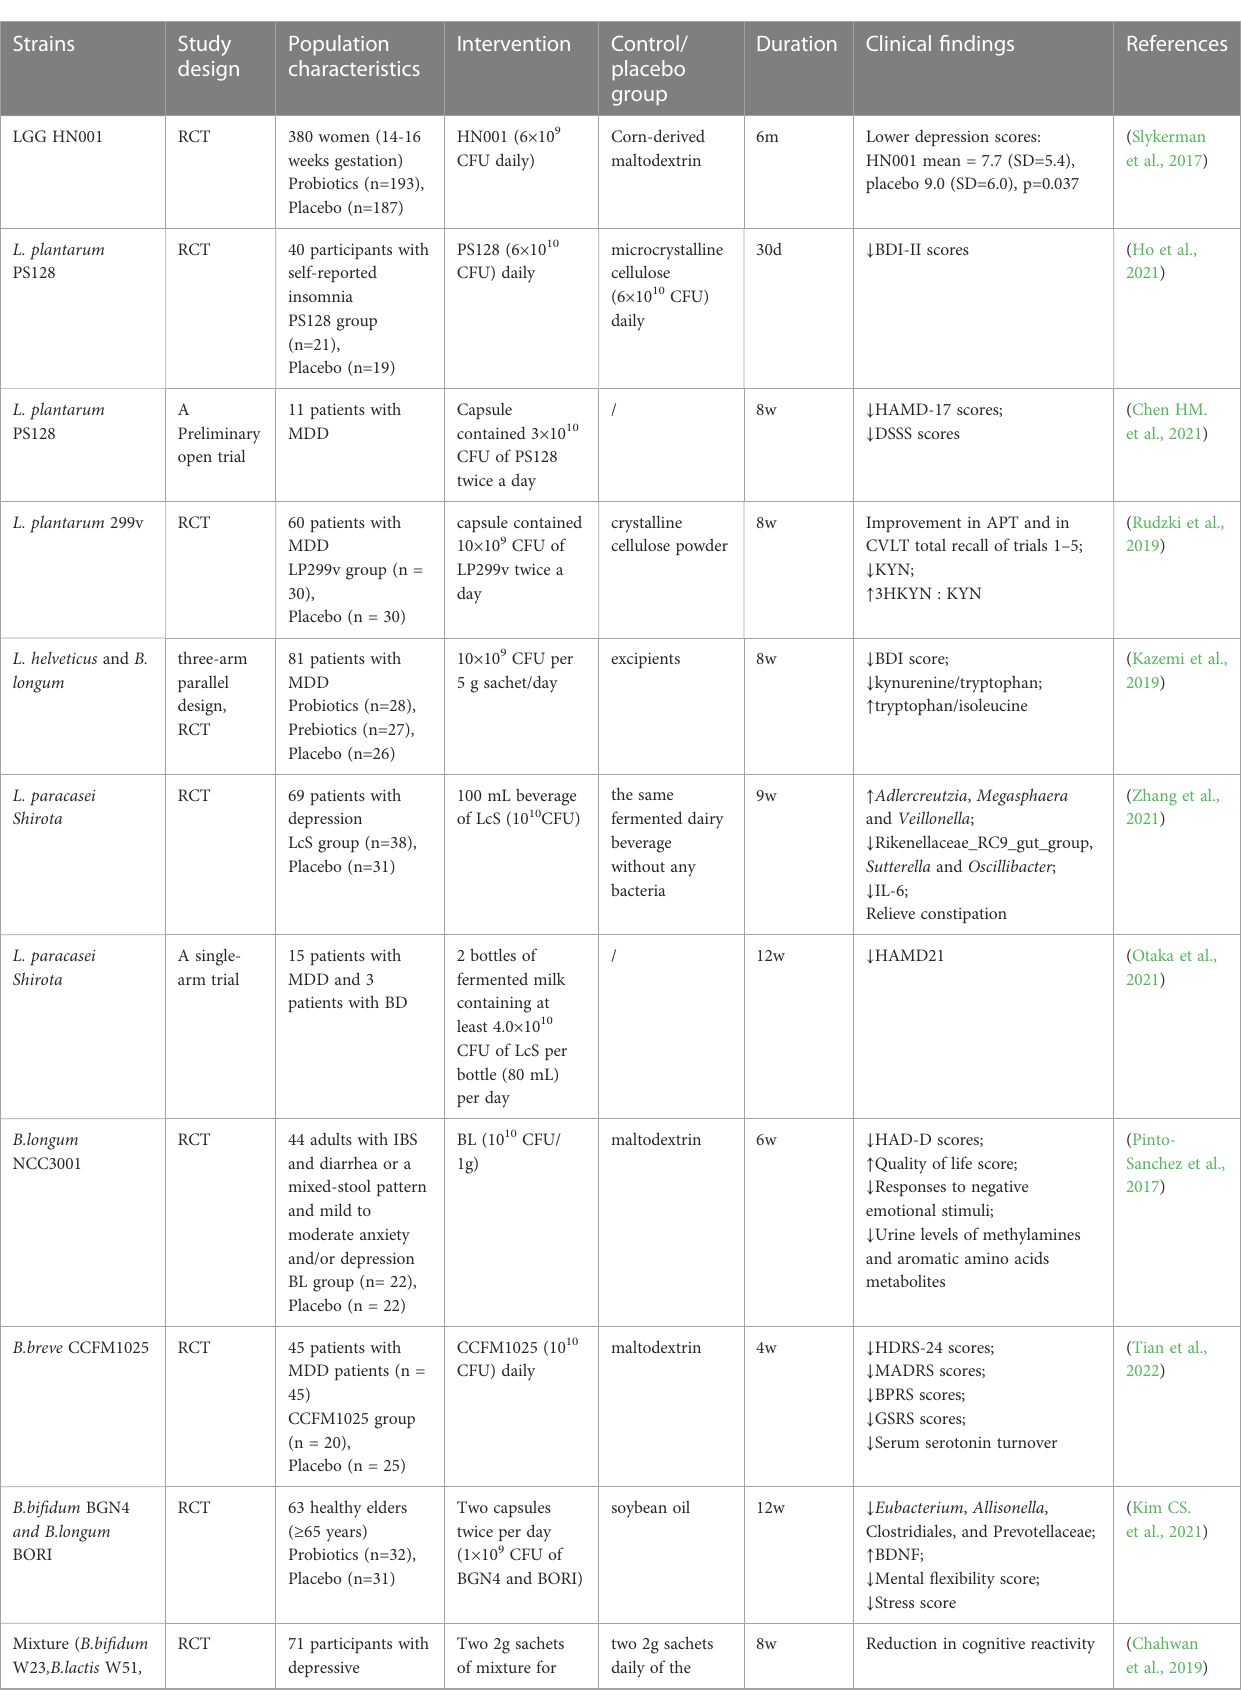
TABLE 1 Clinical evaluation of probiotics on depression and its